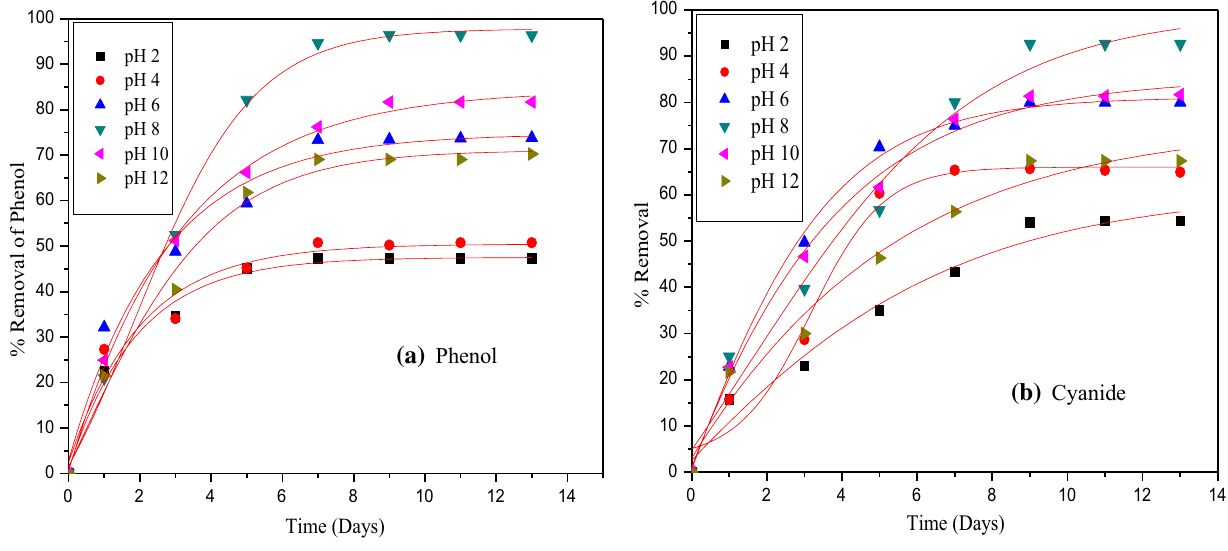
Fig. 8 Effect of pH on removal of phenol and cyanide from binary component synthetic/simulated wastewater by Eichhornia crassipes a phenol b